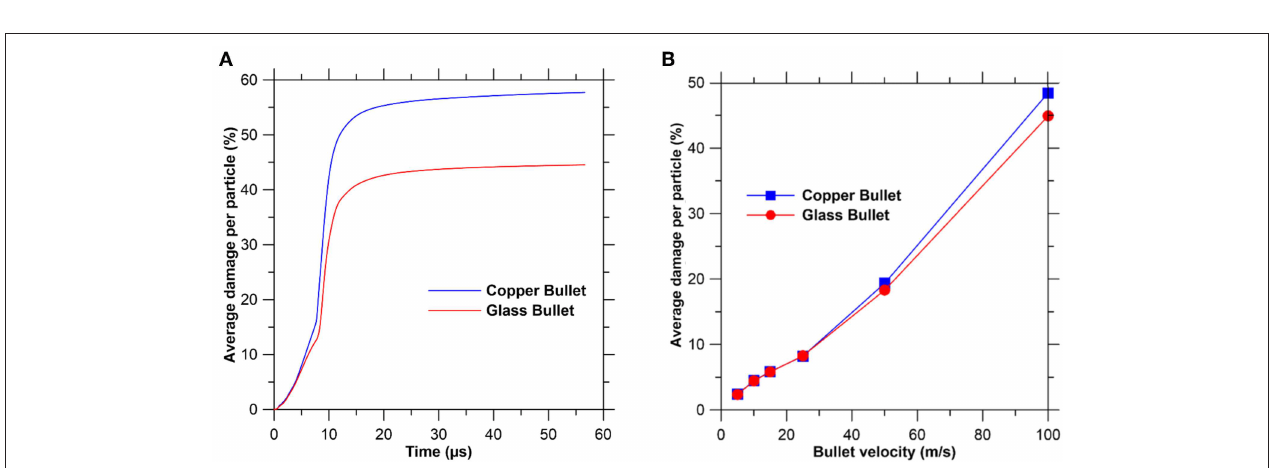
FIGURE 4 | (A) Average damage per particle of the glass plate with respect to time upon impact with copper and glass bullets having a velocity of 100 m/s. (B) Average damage per particle, after saturation, of the glass plate with respect to bullet velocity for copper and glass bullets. Note that the results correspond to that of a glass plate with a radius of 37mm, thickness of 2.5mm, elastic modulus of 94.5 GPa, and fracture energy of 4.3 J/m 2